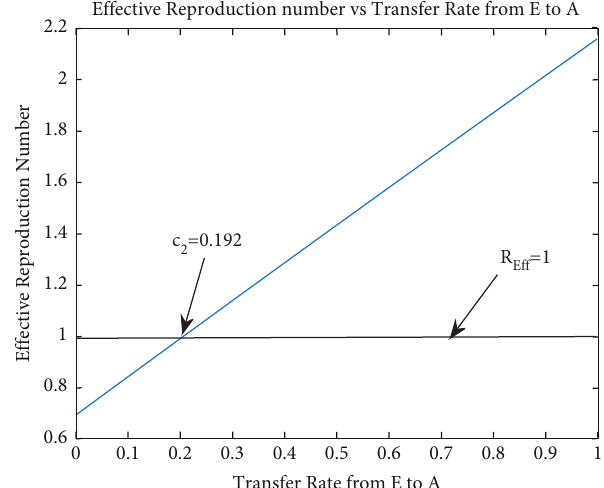
Figure 7: Behavior of effective reproduction number in relation to c